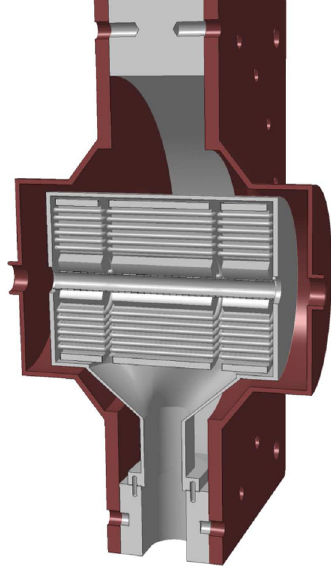
FIG. 48. A 3D view of the intertank section between two CH cavities including the quadrupole